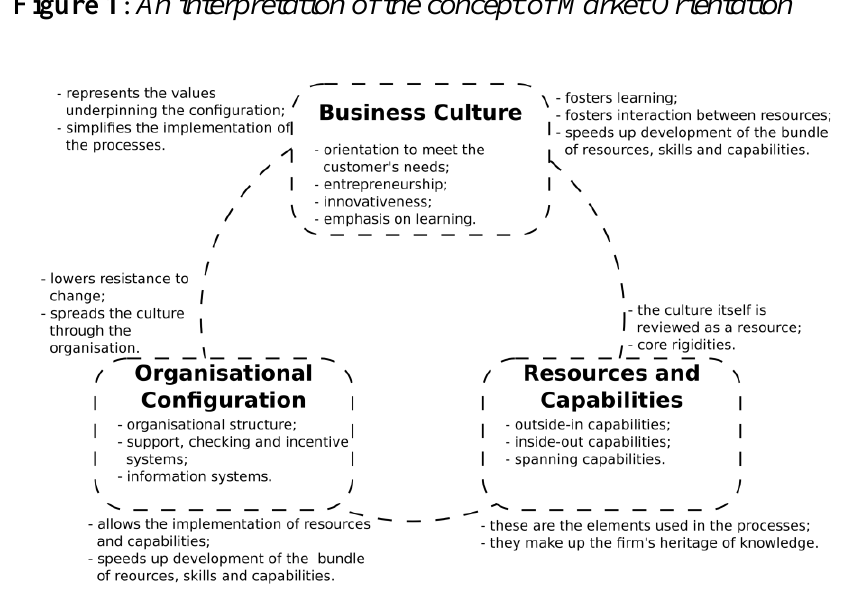
Figure 1 : An interpretation of the concept of Market